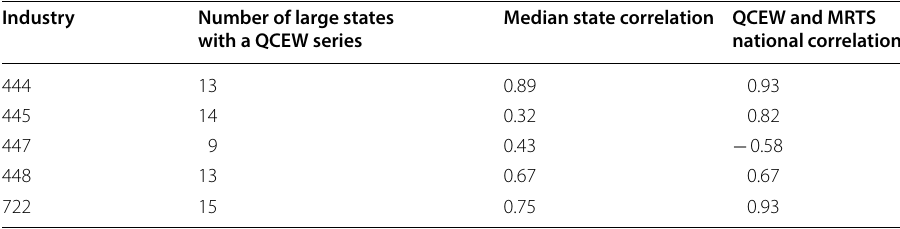
Table 9 Correlations between state-level retail sales estimates and QCEW estimates Industry Number of large states with a QCEW